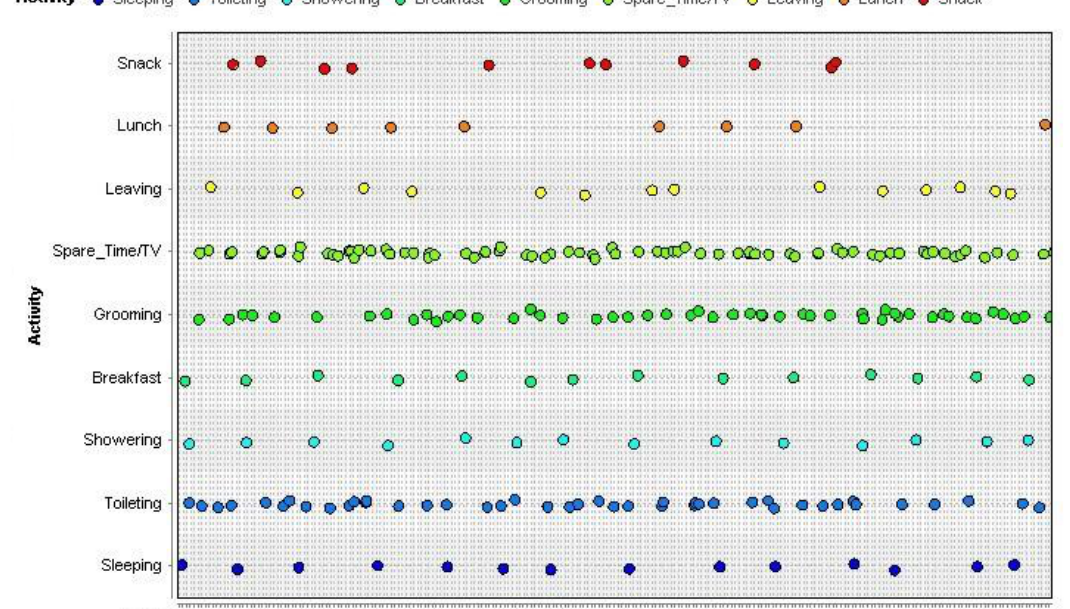
Figure 1. Frequency of performed activities in Ordzonez dataset for one week.